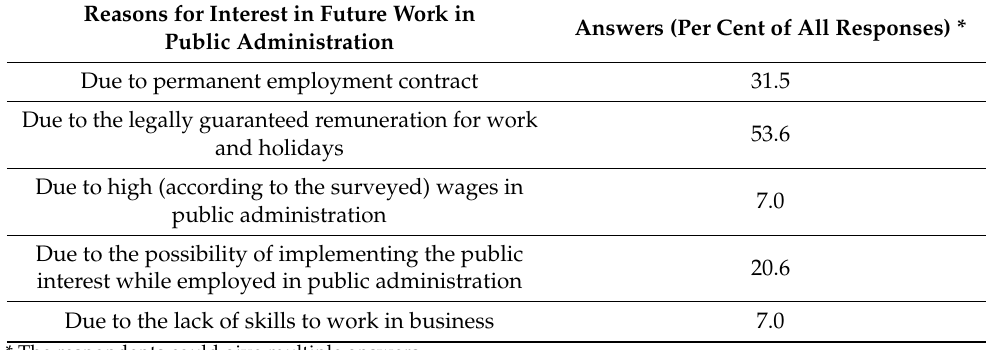
Table 5. Reasons for interest in future work in public administration.